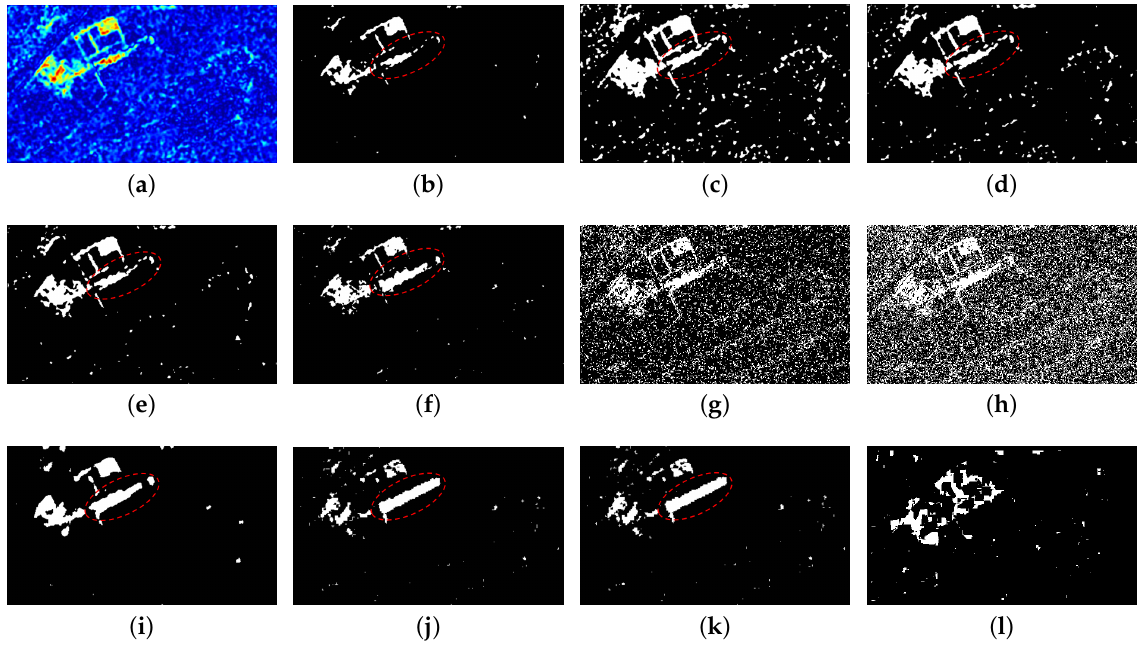
Figure 8. CMs of the different methods on Dataset #4. ( a ) DI of proposed method. ( b )